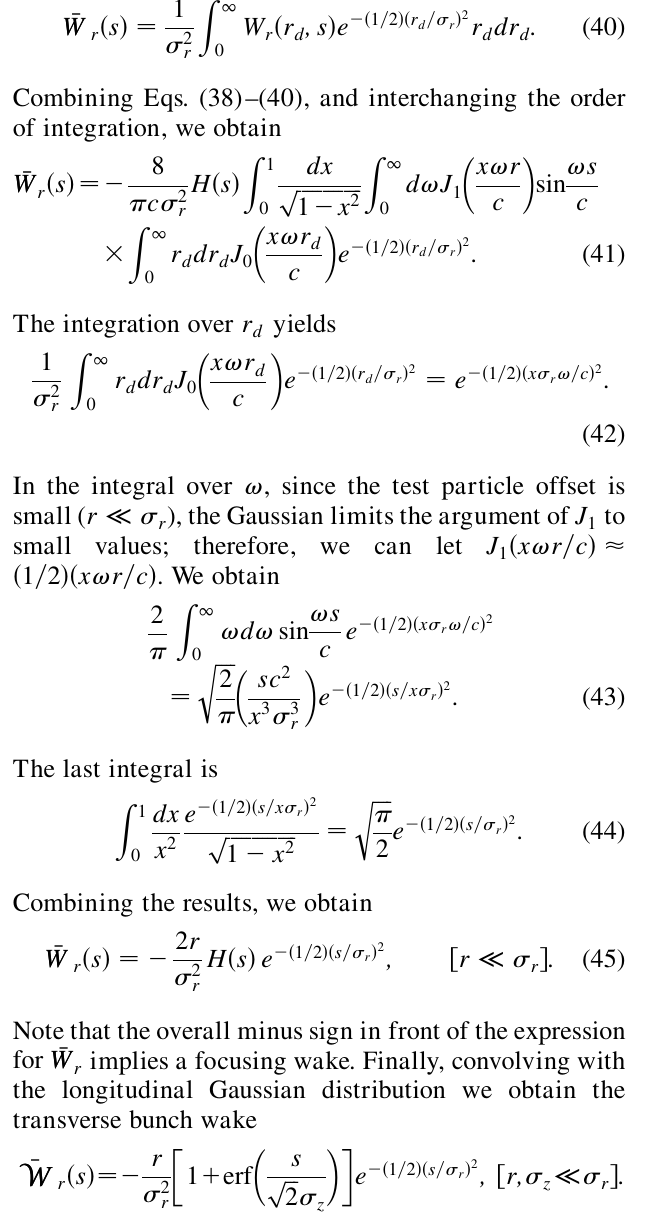
Fig. 6. Note that for small r=(cid:3) becomes resistive and for large r=(cid:3)